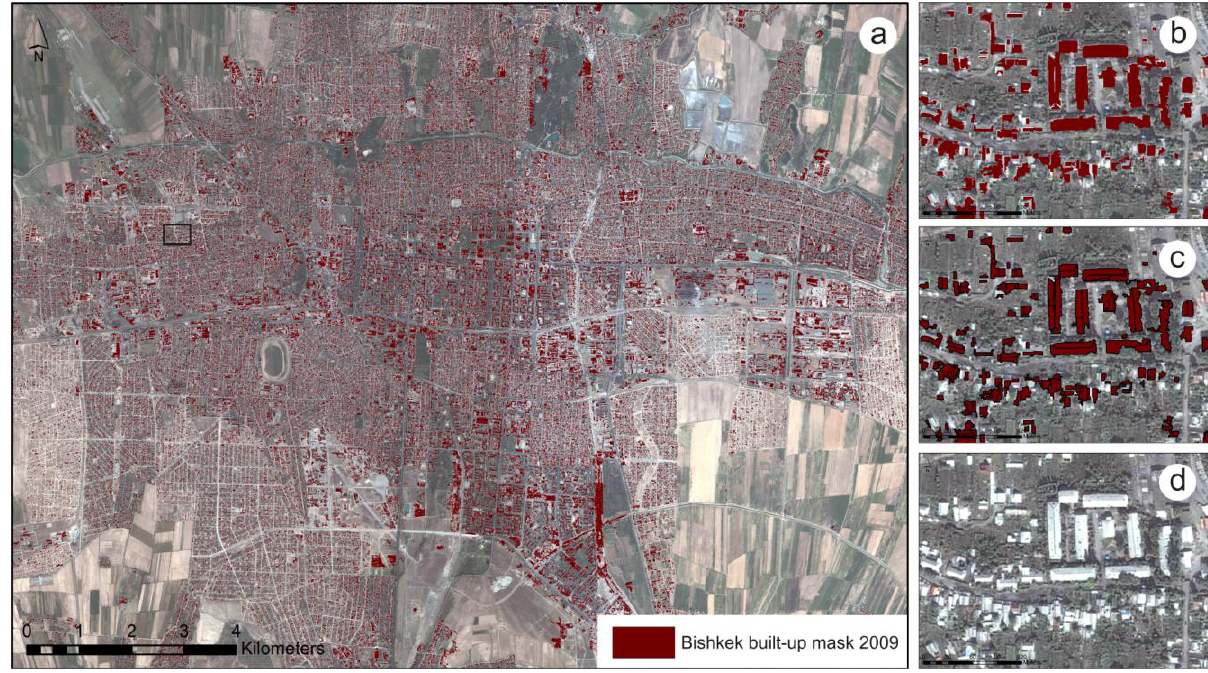
Figure 5. Results of the analysis of high-resolution satellite imagery. ( a ) Built-up units for 2009 in Bishkek and magnification of the rectangular area of ( b ) the built-up units, ( c ) the built-up segments composing the built-up units, ( d ) the input Quickbird image from 2009.